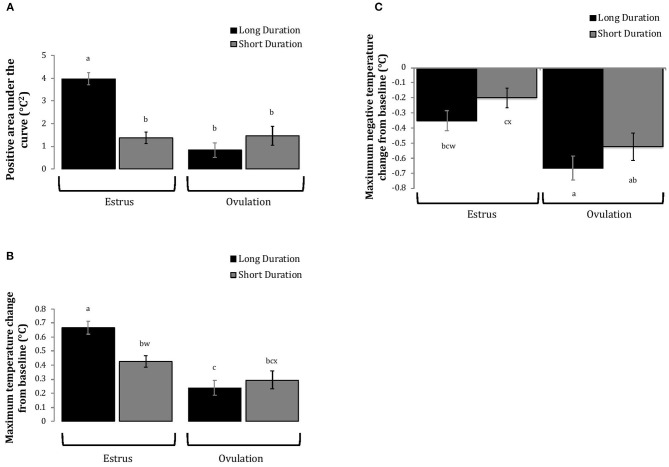
Changes in rumen-reticular temperature relative to baseline (least squared means± SE) during estrus and near ovulation in Holstein dairy cows expressing a long or short durations of estrous expression, obtained from a mixed linear regression model as described in Table 1. The following three temperature changes are depicted: positive area under the curve [(A); P < 0.001], maximum change [(B); P < 0.01], and maximum negative change [(C); P < 0.01]. Superscripts of letters a-c denote significant differences (P < 0.05), while letters w-x denote tendencies (0.05 ≥ P < 0.10), between all groups of each panel. Low peak activity: estrous expression less than the median. Long duration: estrous expression lasting longer than the median of 12 h.